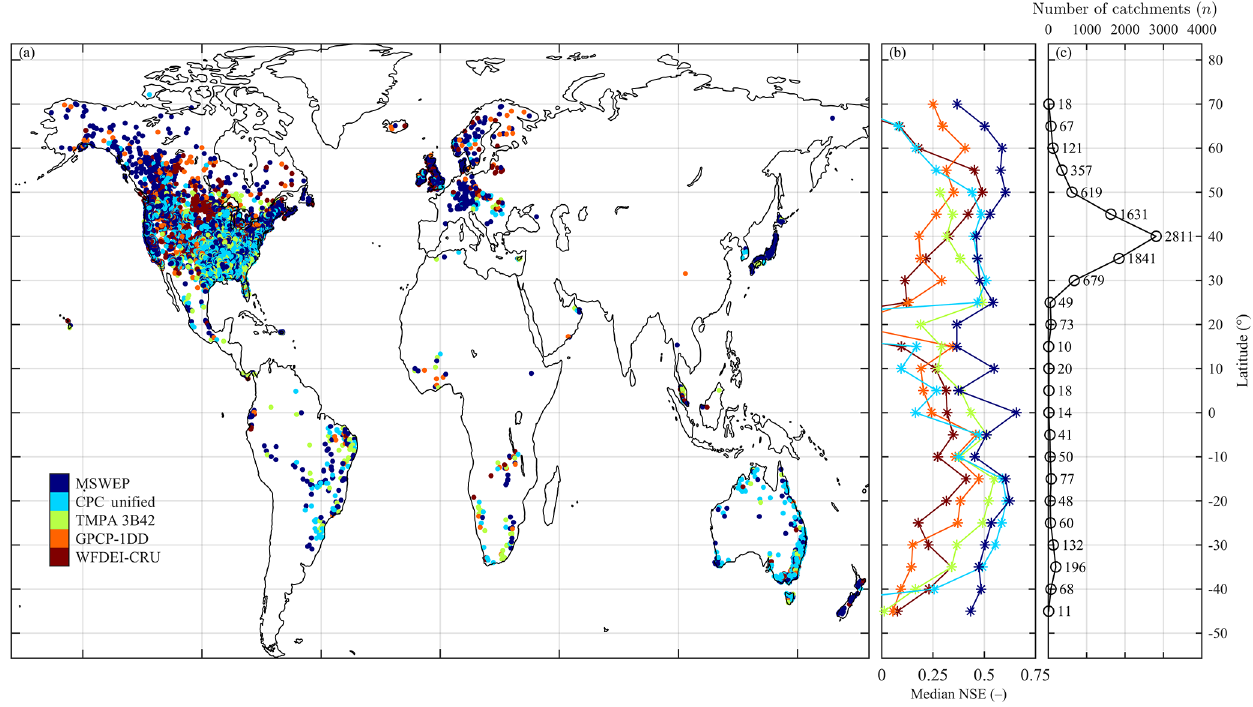
Figure 10. The P dataset with the best daily NSE score obtained after calibration of HBV is shown in (a) . Also shown are (b) median NSE scores for 5 ◦ latitude bands and (c) the number of catchments ( n ) for each 5 ◦ latitude band. Each data point in (a) represents a catchment centroid ( N = 9011). The NSE scores have been computed between simulated and observed Q time series.